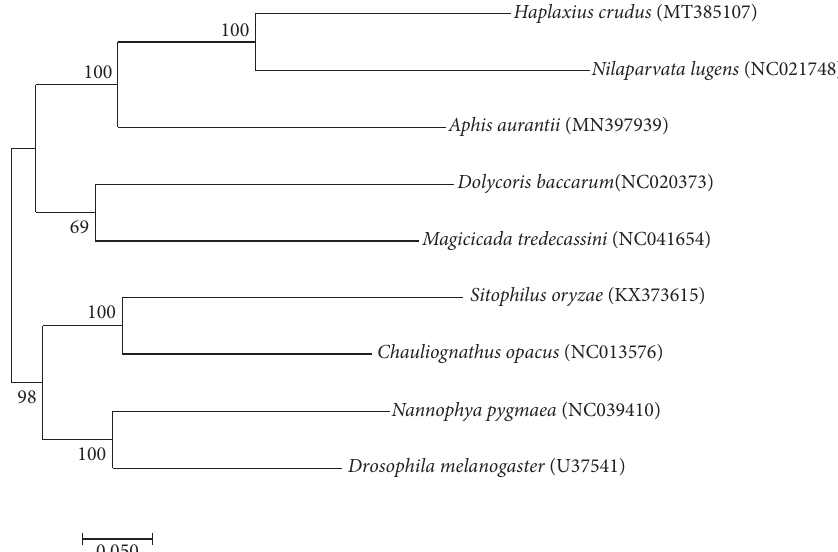
Figure 4: Maximum likelihood phylogenetic reconstruction at 1,000 bootstrap replicates of ten insect species based on the mitochondrial genome using the Tamura–Nei